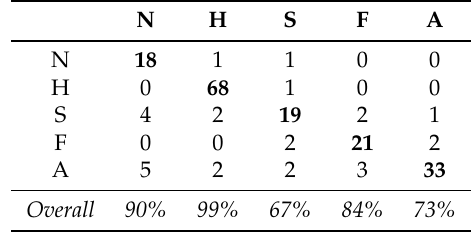
Table 4. Facial Expression Recognition performance on the CK+ dataset (N = Neutral; H = Happiness; S = Sadness; F = Fear; and A =